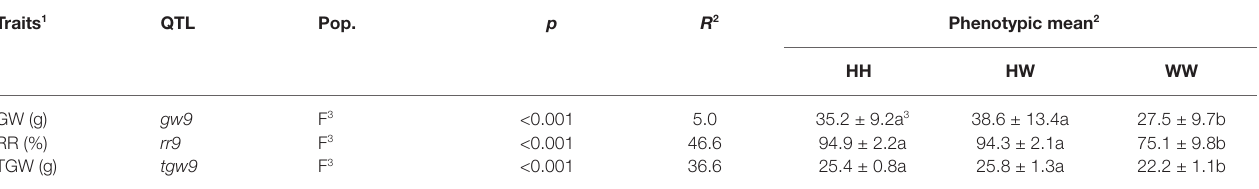
TABLE 2 | Quantitative trait loci (QTL) for the three traits based on a single-point analysis in the F 3 population. Traits 1